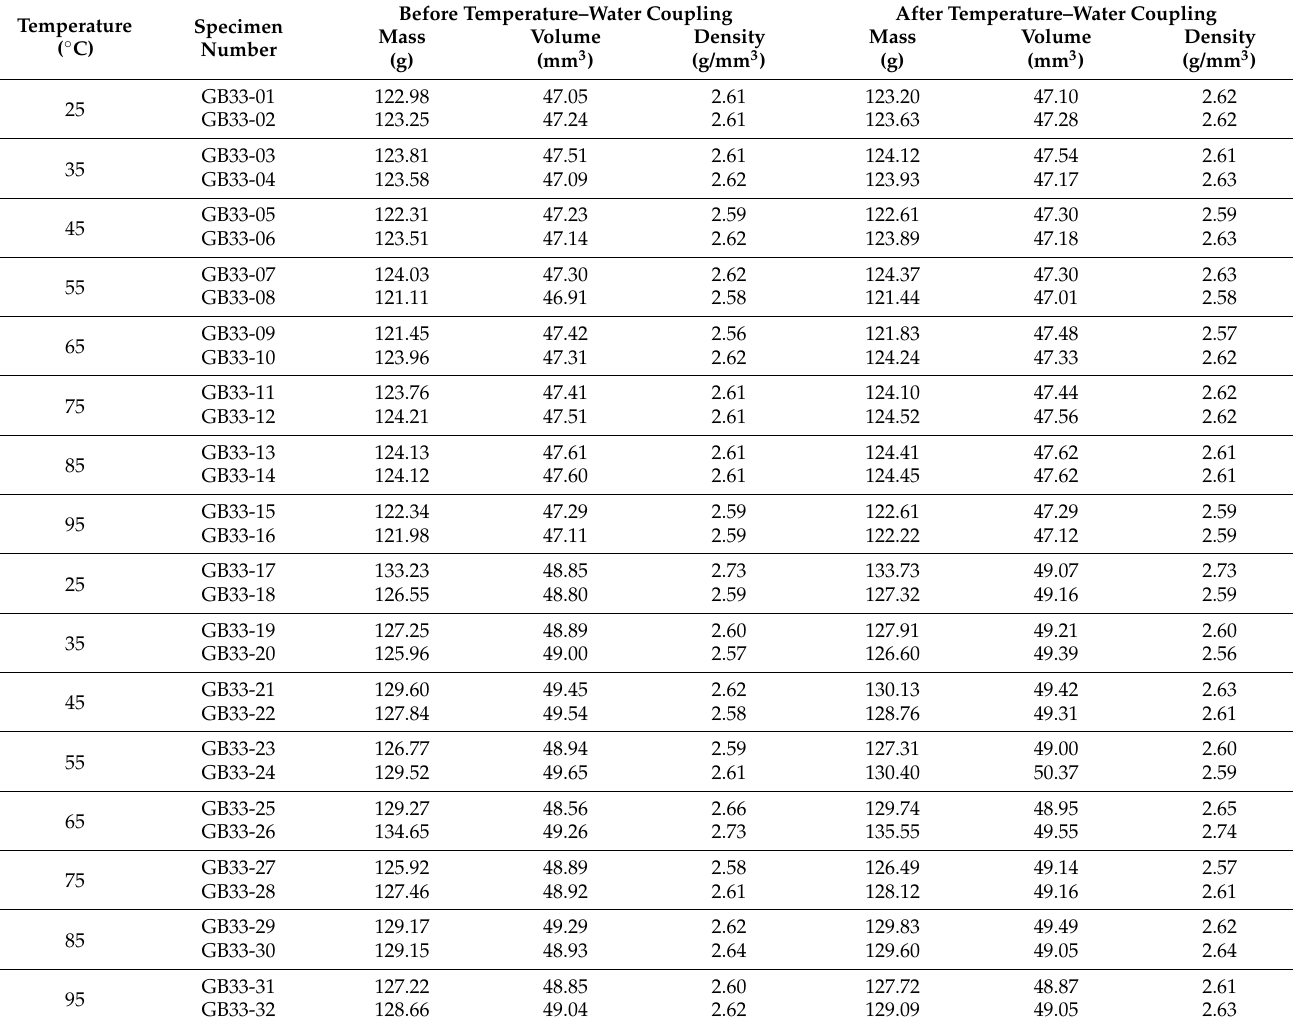
Figure 4. The apparent morphology of sandstone specimens after the effect of temperature–water coupling. As can be seen from the picture, the increase in the water temperature lightens the surface color of the specimen. The specimen numbers also gradually became blurred under the temperature–water coupling effect. When touching the specimens’ surface gently with the hand, the higher the water temperature, the stronger the surface frosting feeling, and the more granular fine sand floating on the specimen surface. Before and after the temperature–water coupling effect, the physical basic data of the sandstone specimens were calculated, and the results are shown in Table 1. Table 1. Comparison of physical data before and after temperature–water